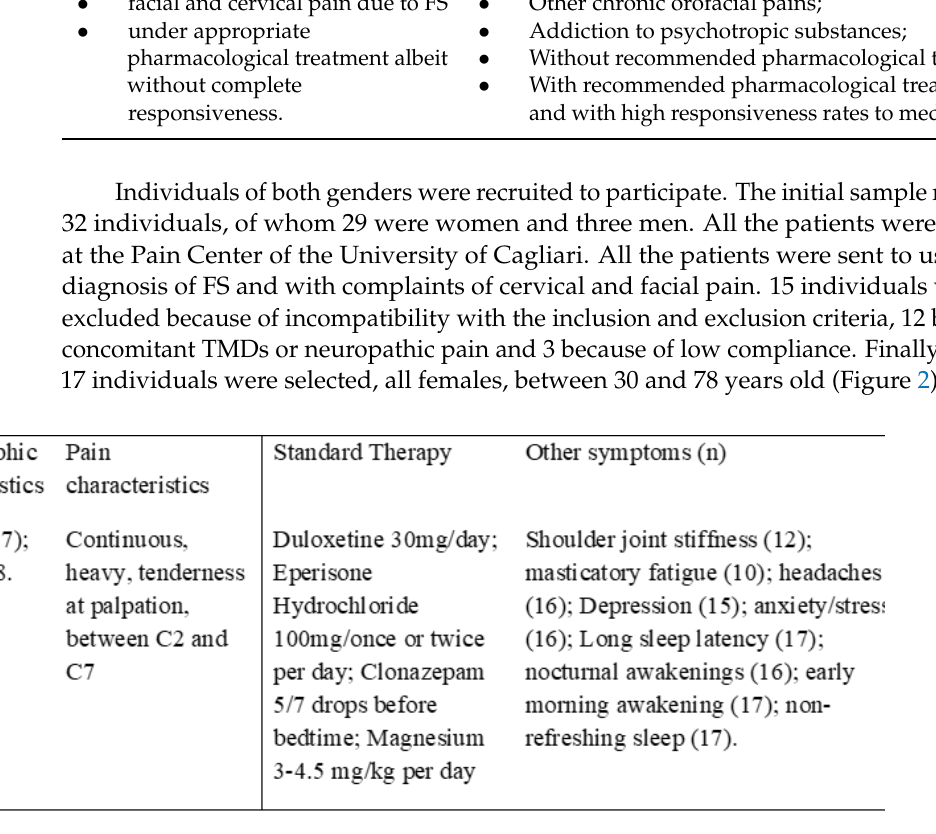
Figure 2. General characteristics of the included